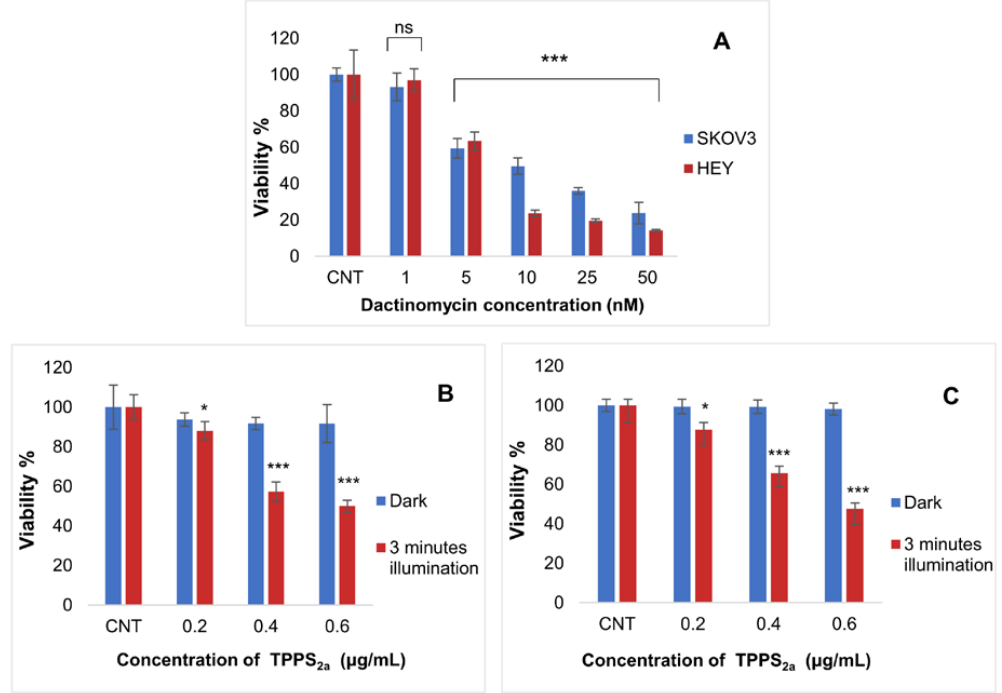
Figure 3. Toxicity of different dactinomycin concentrations using 24 h incubation on SKOV3 and HEY cell viability in monolayer culture ( A ) as well as viability of SKOV3 ( B ) and HEY ( C ) cells in monolayer cultures post PDT treatment using different concentrations of TPPS 2a . For PDT the cultures were treated using a blue lamp at wavelength of 420 nM (light power of 7 mW/cm 2 ) and total light dose of 1.26 J/cm 2 (3 min). MTT was carried at termination stage. 1 nM is approximately 0.001255 µ g /